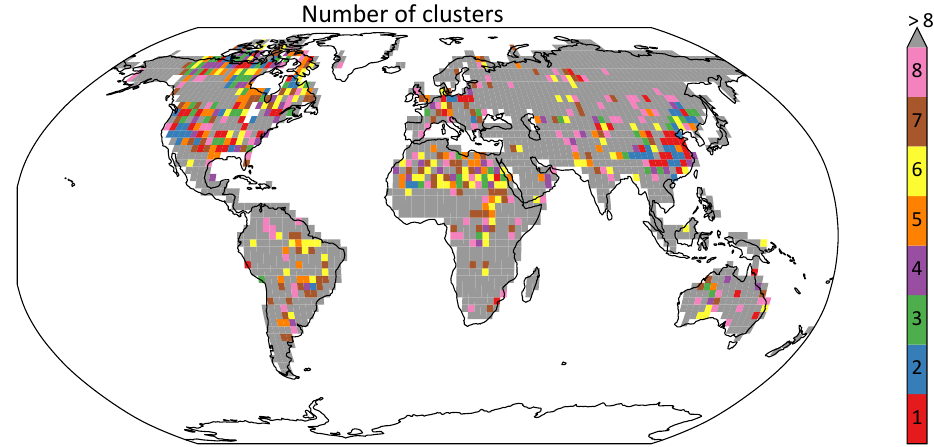
Figure A4. Global distributions of the number of clusters (tiles) found per CLASS-CTEM grid cell when minPts (see Sect. 2.3) is set to 1% of the number of GSDE data points in the CLASS-CTEM grid cell. The gray regions have more than eight tiles found by the clustering algorithms.